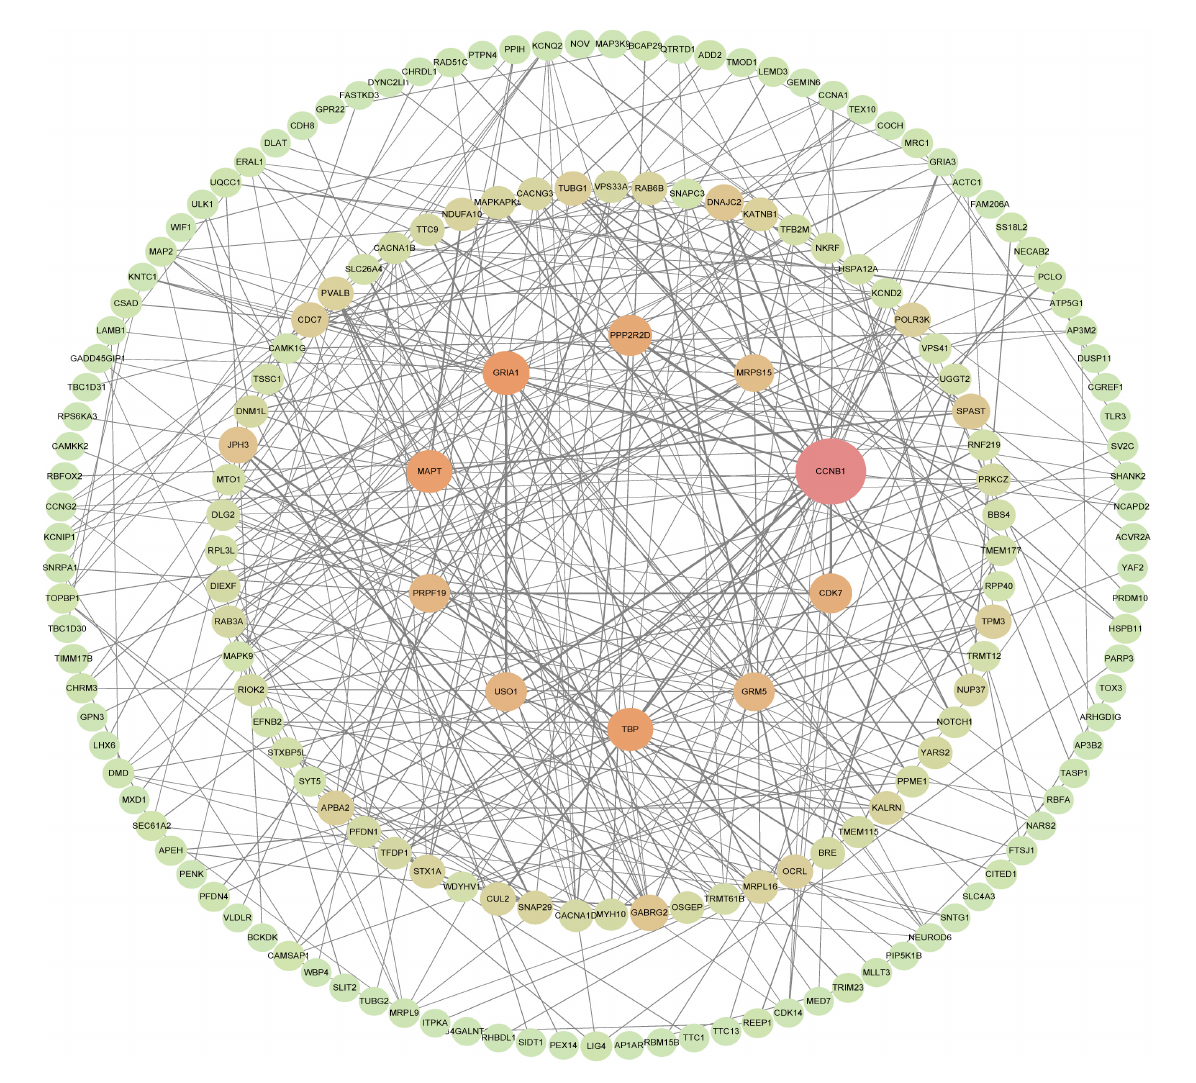
FIGURE7 PPI network of hub genes, PPI network of genes constructed in the STRING database. Then, visualization of a STRING-derived network of molecular interactions in Cytoscape pathway visualization and analysis software, the 10 genes in the middle are the key genes to be screened, and the closer the color is to red, the higher the